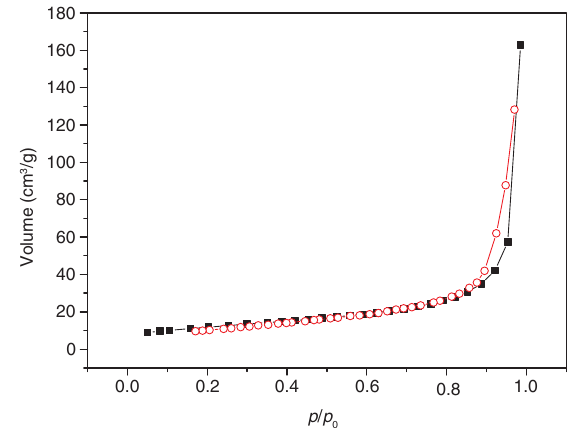
Figure 4: Dependence of adsorbed gas volume on cm 3 /g, on rela- tive pressure p / p 0 (black line – adsorption branch of the sorption isotherm; red line – desorption branch).